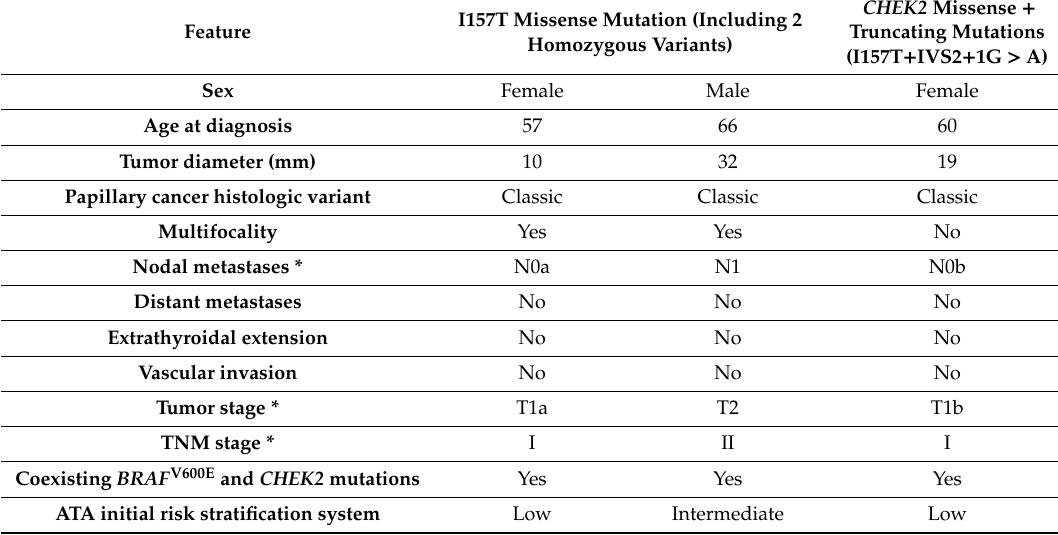
Table 2. Clinical characteristics of patients with PTC carrying two CHEK2